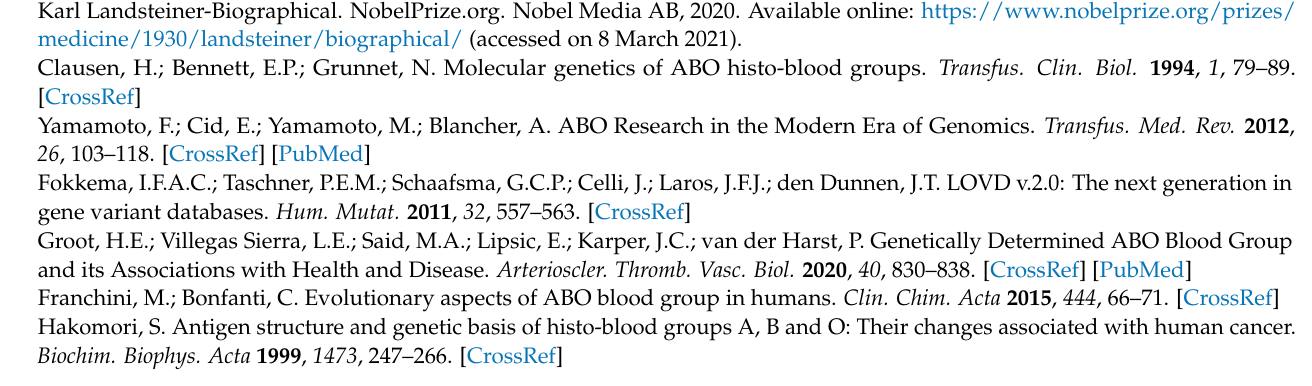
the 1000 Genomes. Table S1. Summary of the general and by-type baseline characteristics. Table S2. Distribution of ABO blood types across Asian ethnicities. Table S3. Summary of GWAS on the binary trait of O vs. non-O blood types. Table S4. Summary of GWAS on the binary trait of A vs. non-A blood types. Table S5. Summary of GWAS on the binary trait of B vs. non-B blood types. Table S6. Summary of GWAS on the binary trait of AB vs. non-AB blood types. Table S7. Summary of GWAS on the quaternary trait of A vs. O blood types. Table S8. Summary of GWAS on the quaternary trait of B vs. O blood types. Table S9. Summary of GWAS on the quaternary trait of AB vs. O blood types. Table S10. Frequency summary of individuals with the defined set of SNPs ( n = 916). Table S11. Summary of individuals with wrongly predicted ABO blood types ( n =